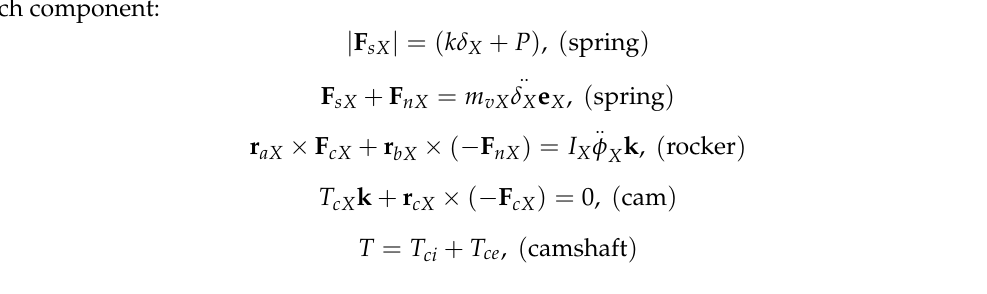
Table 2. Notations used in derivation of the force and moment equations for the camshaft analysis.